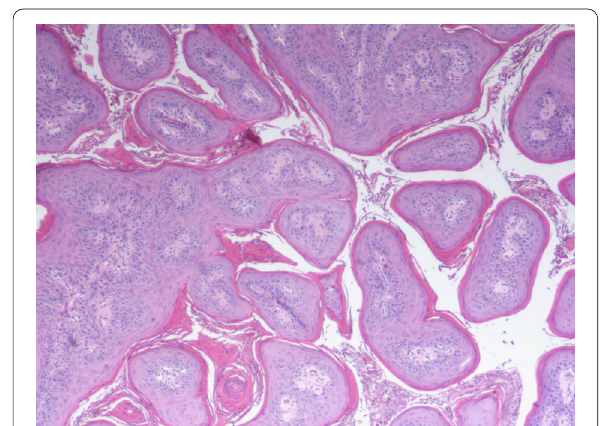
Fig. 2 Histological findings: squamous epithelial papillary